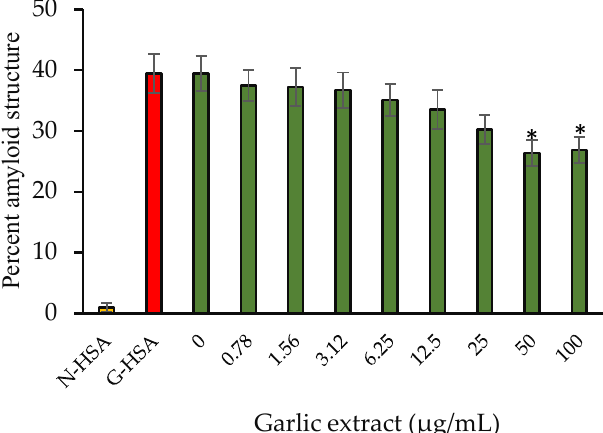
Figure 5. Percentage aggregation vs. concentration of garlic extract. Native HSA and G-HSA were incubated for 10 weeks and served as negative and positive controls, respectively. G-HSA was incubated with various concentrations (0–100 µ g/mL) of garlic extract (green). The results are presented as means ± SEM ( n = 3). All the percentage inhibition of protein aggregation results (0.78–100 µ g/mL garlic extract) were compared with G-HSA sample. Comparison between two groups was performed based on t test, and significance was defined as * p < 0.05, ** p < 0.01, *** p < 0.001.